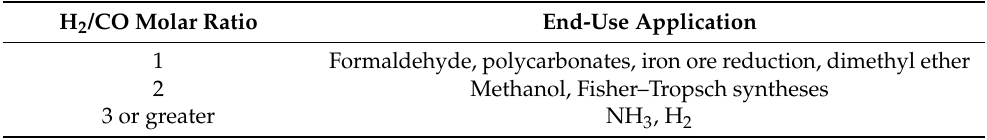
Table 4. Synthesis gas end-use applications depending on the H 2 /CO ratio [52,60,118,119]. H 2 /CO Molar Ratio End-Use